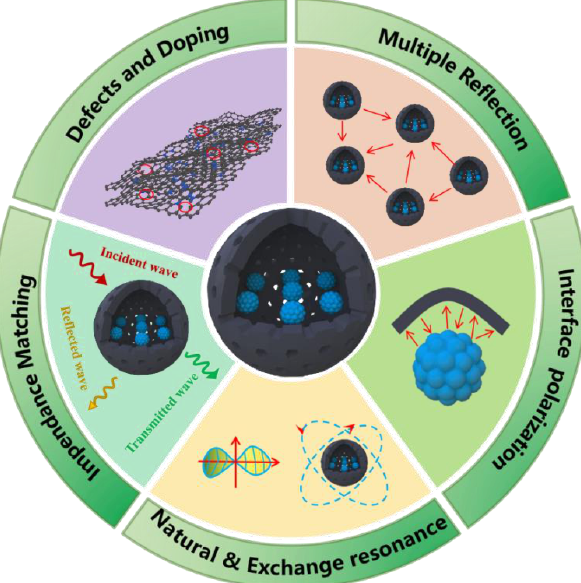
Figure 12. Schematic diagram of the microwave absorption mechanism of Fe@C-12.